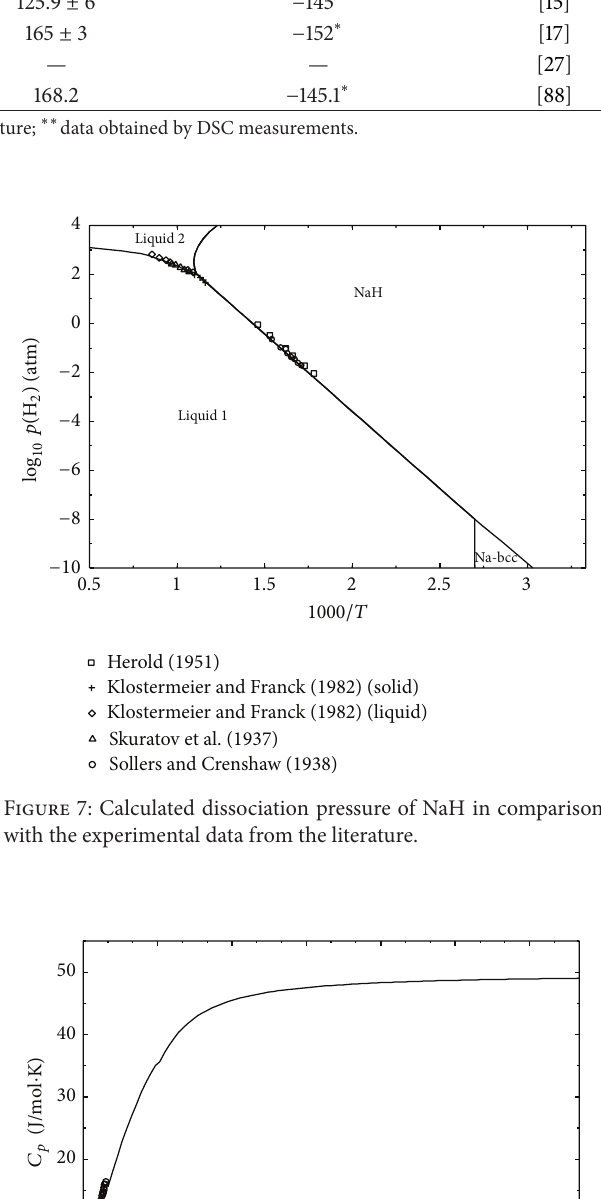
Table 5: Thermodynamic properties of NaMgH